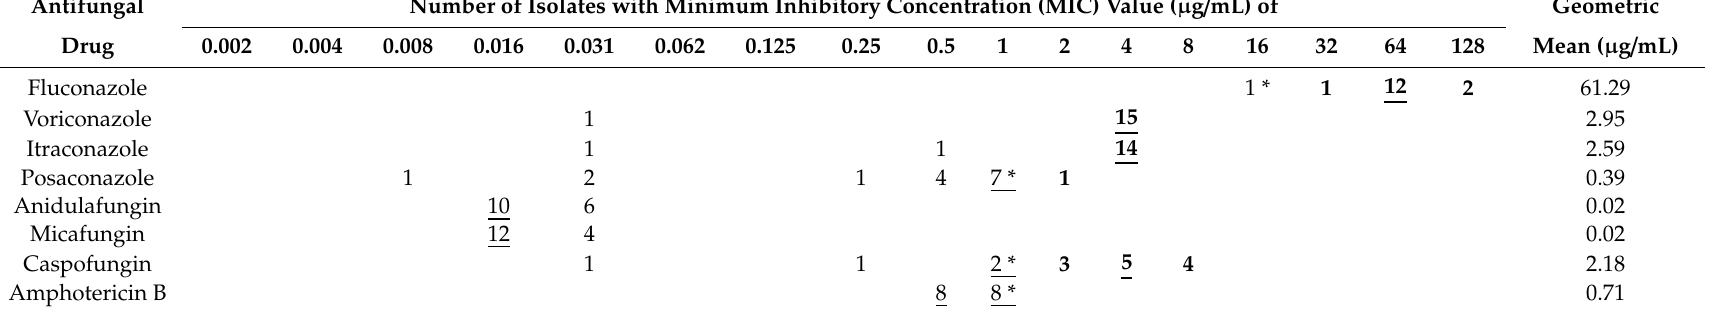
Table 2. In vitro antifungal susceptibility testing results of C. auris bloodstream isolates ( n = 16) against fluconazole, voriconazole, itraconazole, posaconazole, anidulafungin, micafungin, caspofungin and amphotericin B after 24 h of incubation at 35 ◦ C.